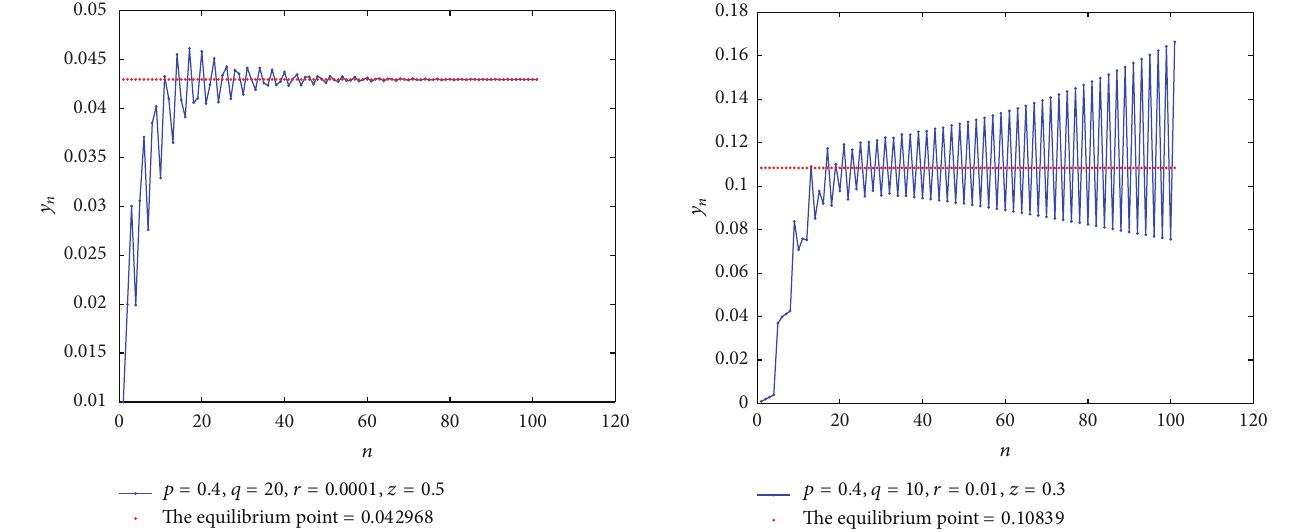
Figure3:Dynamicsof 𝑦 𝑛+1 = (0.01+0.4𝑦 𝑛 +𝑦 𝑛−3 )/(0.3+10𝑦 𝑛 +𝑦 𝑛−3 )